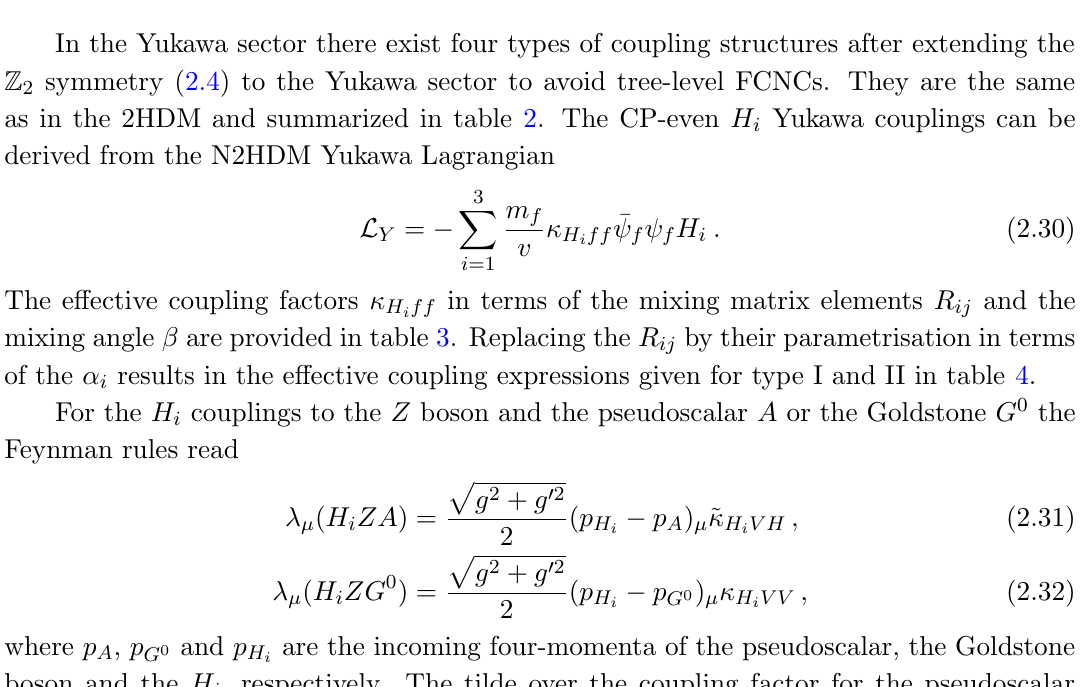
Table 3 . Coupling coe(cid:14)cients (cid:20) H de(cid:12)ned in eq.